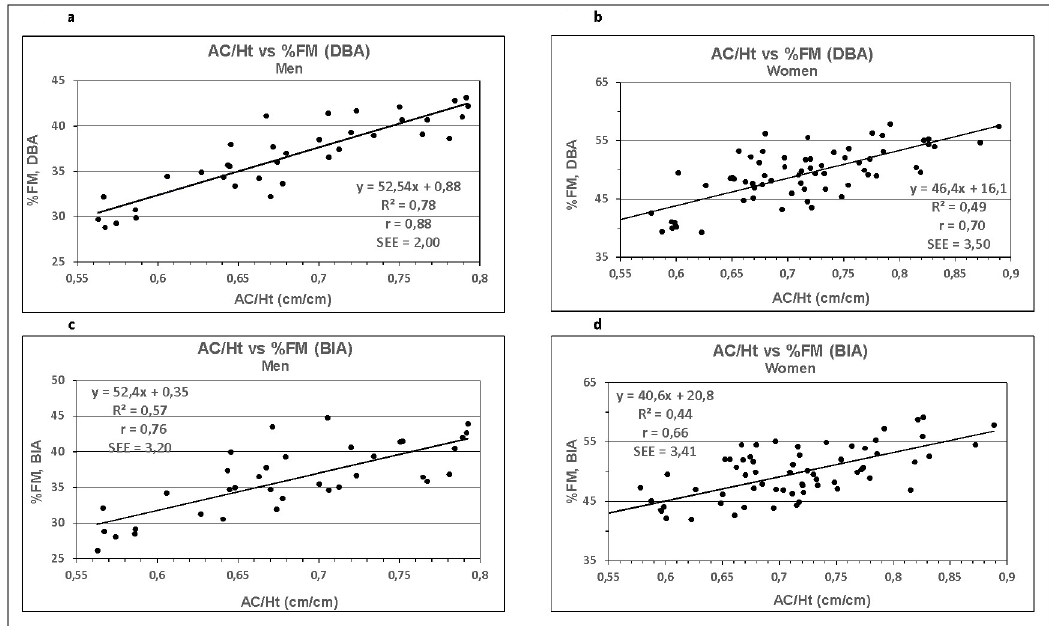
Fig 1. a-d: Relationship between AC/Ht vs. %FM derived by DBA and BIA method for men (Fig 1a and 1c) and women (Fig 1b and 1d). Solid line: regression line; R 2 : determination coefficient; r: Pearson´s correlation coefficient; SEE: standard error of estimate.